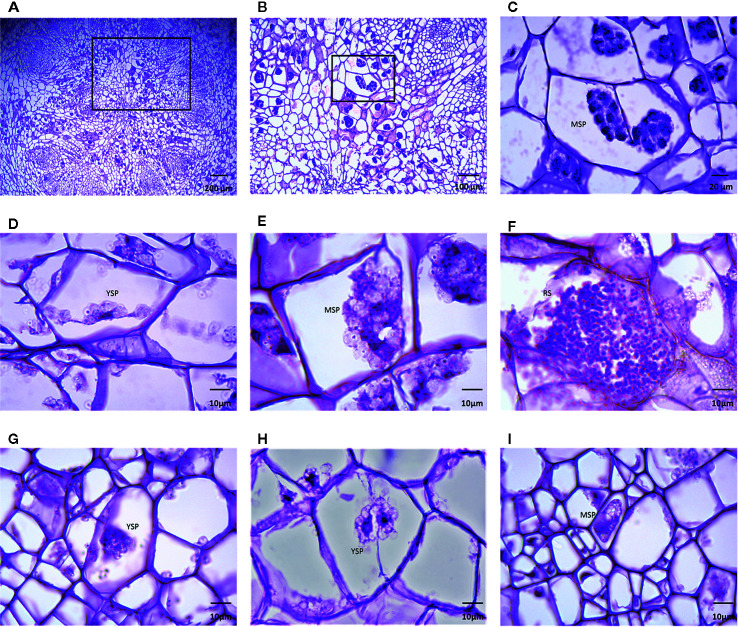

Plasmodiophora brassicae infection on roots 21 dai. A cross-section through a large root gall of Brassica napus ‘Brutor’ (A), showing the presence of secondary plasmodia, which are visible in more detail under higher magnification (B, C). Young and advanced secondary plasmodia were also visible in other sections of the susceptible ‘Brutor’ (D–F), as well as in the resistant B. napus ‘Laurentian’ (G–I). Mature secondary plasmodia (MSP), young secondary plasmodia (YSP), resting spores (RS).